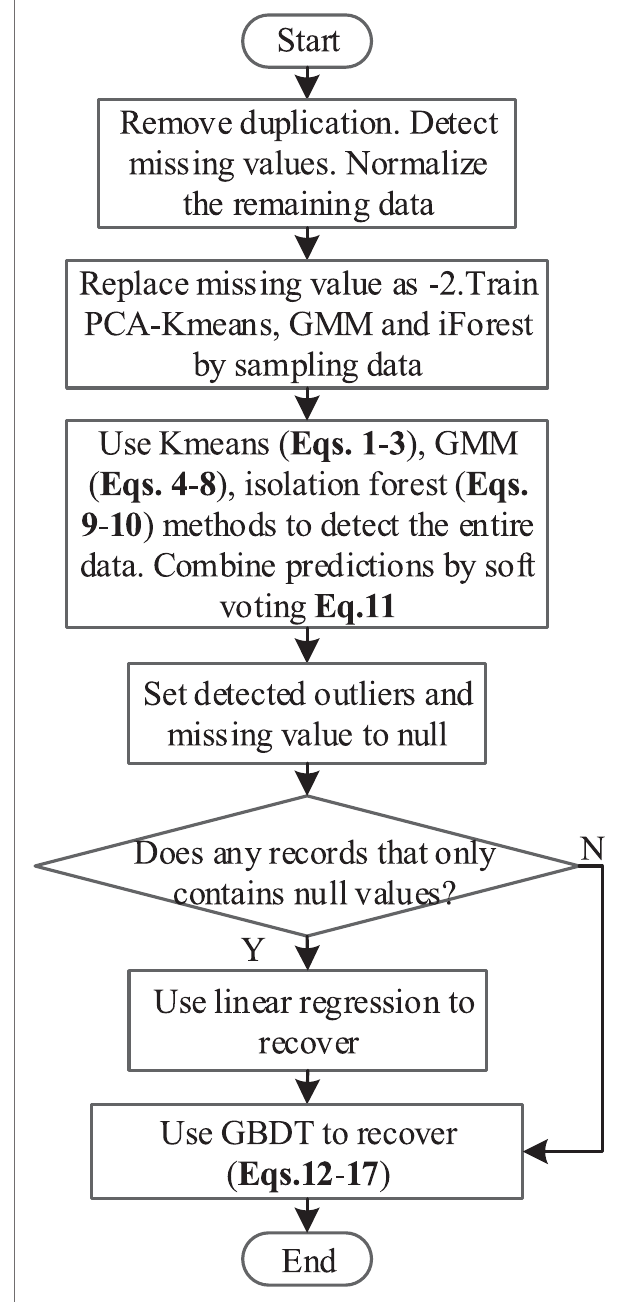
FIGURE 4 | The fl owchart of the proposed